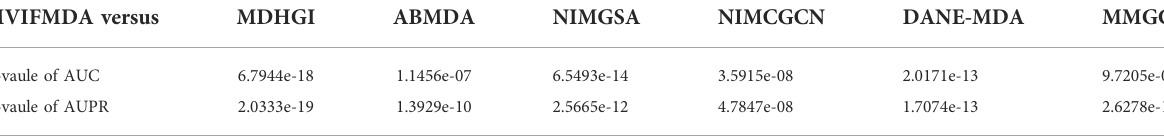
TABLE 3 The statistical results by paired t -test for MVIFMDA and all comparison methods.